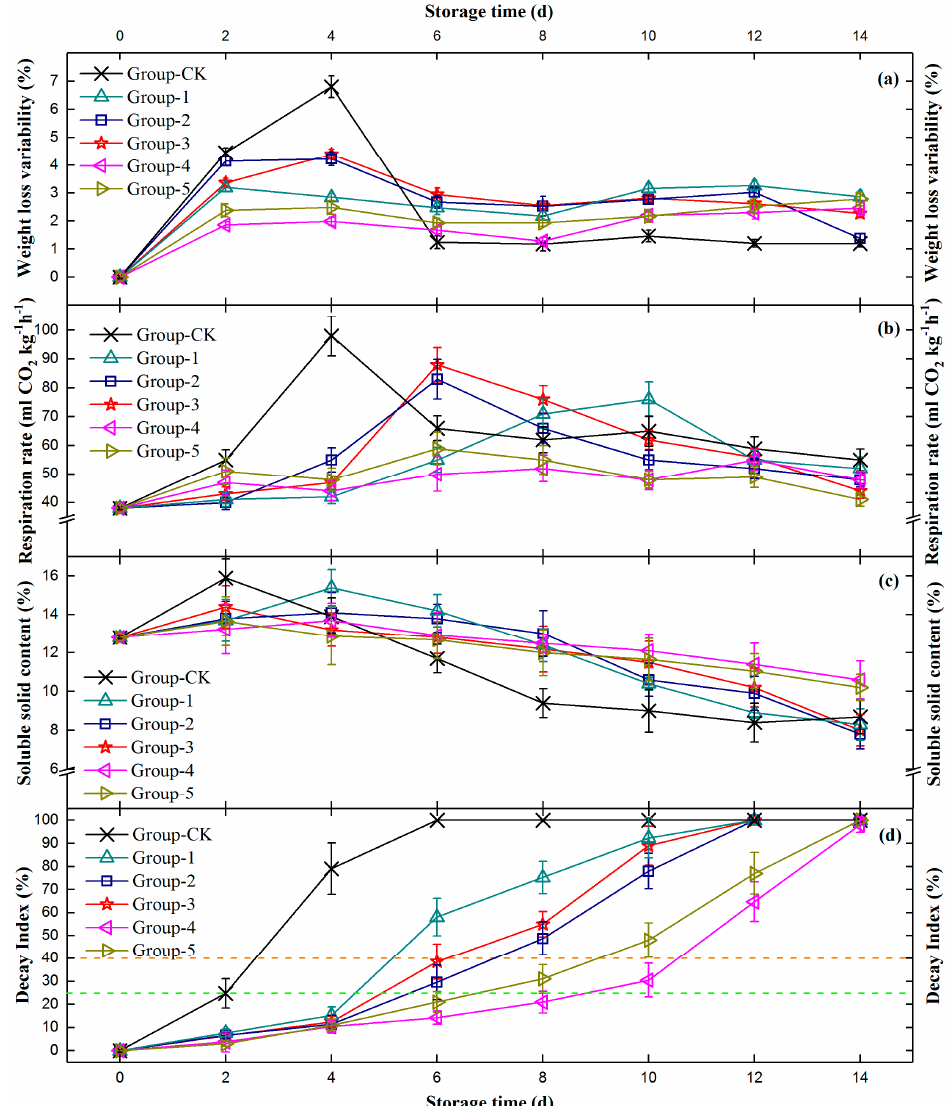
Figure 3. Physiological and organoleptic variations from different treatment groups. ( a ) WL, %; ( b